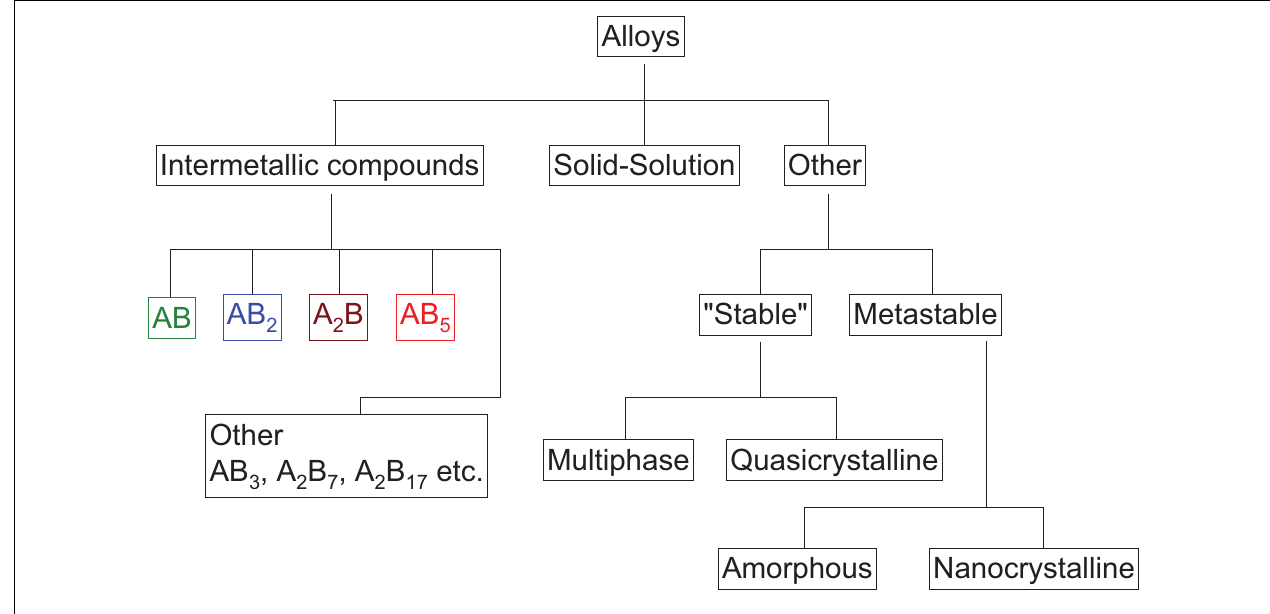
FIGURE 3 | Family tree of metal hydrides (Sandrock, 1999).